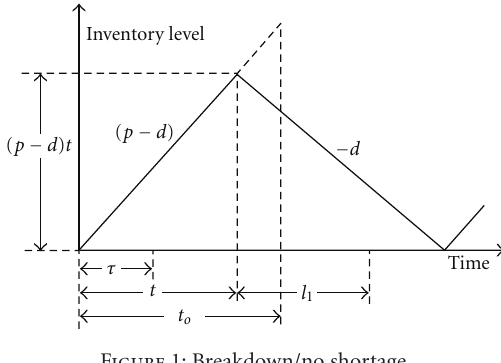
Figure 1: Breakdown/no shortage.